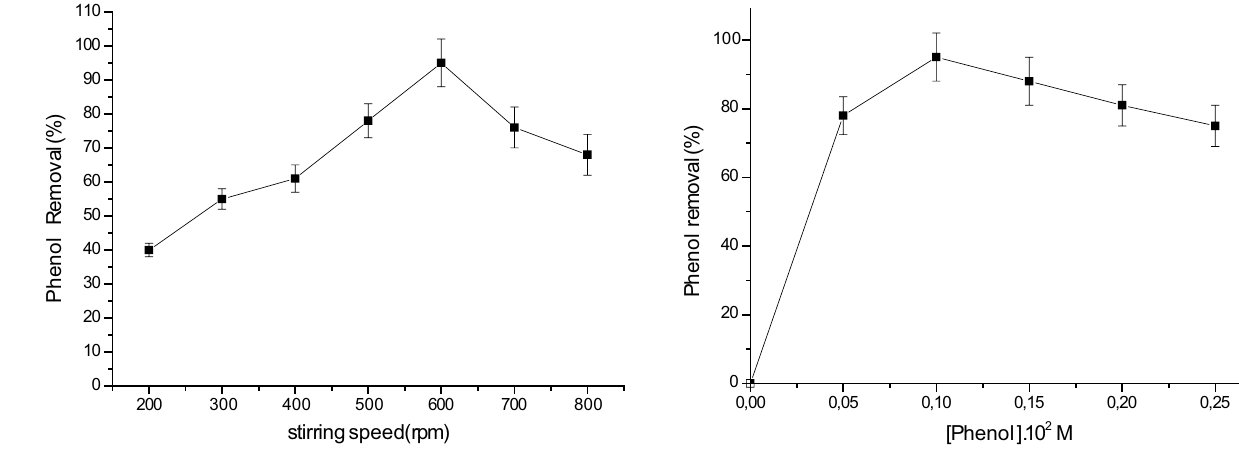
Fig. 5 Effect of initial concentration of phenol. Transport conditions: feed phase: phenol (0–0.0025 M), pH 2. Stripping phase: NaOH 0.20 M. Membrane: 12.60 cm 2 of surface area, calix[4]resorcinarene: RC8 (0.15 g/g mixture of polymers), (0.03 ml 2-NPOE/12.56 cm 2 mixture of polymers) values obtained after 6 days of